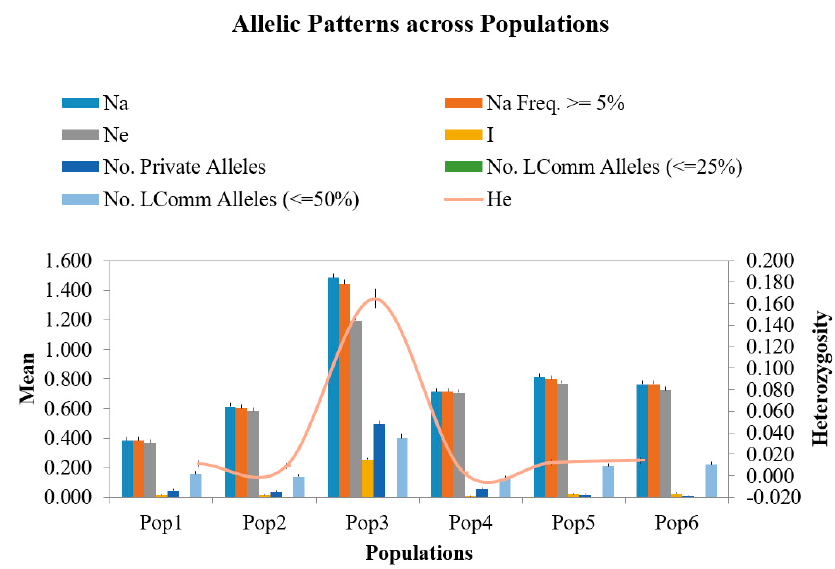
Figure 4. Alleleic patterns across populations.